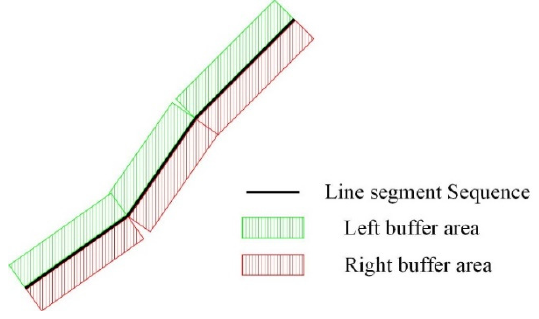
Figure 6. Gray mean comparison diagram.